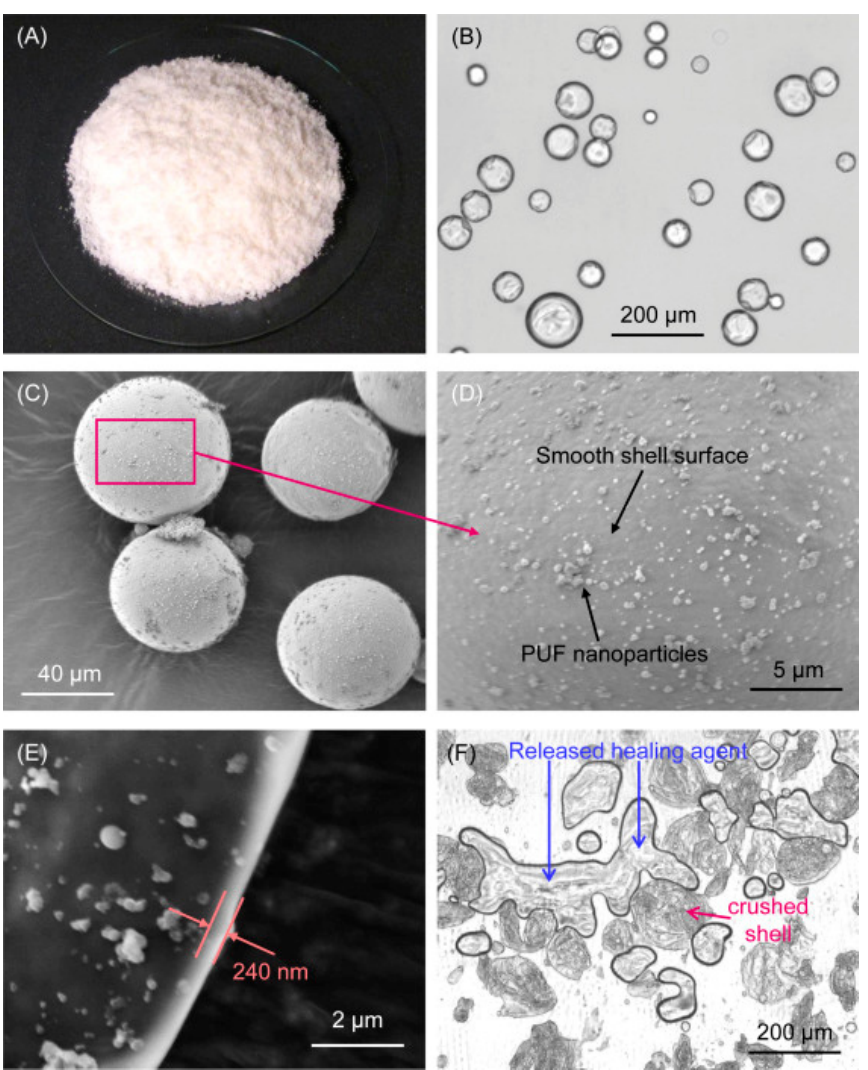
Figure 15. Microcapsules were prepared with a polymerizable TEGDMA–DHEPT healing liquid inside PUF shells. ( A ) Photo showing a pile of synthesized microcapsules. ( B ) Transmitting optical image showing the shell structure as a dark ring. ( C ) SEM image of typical microcapsules. ( D ) High-magnification SEM image of the shell surface showing nanoparticle deposits on an otherwise smooth shell surface. ( E ) High-magnification SEM image indicating the shell thickness. ( F ) Optical image of crushed microcapsules showing the released healing liquid films. Images from [111].